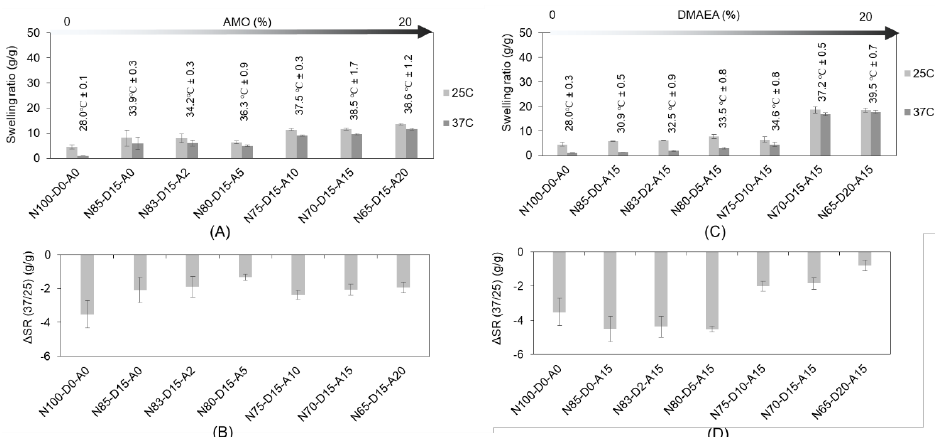
Figure 4. Swelling behavior of three-dimensional scaffold printed from GF-based resins (3% w / w TMPTA, 4% w / w PI, printing time 10 s/layer) at different temperatures (25 °C and 37 °C) with the transition temperature with different ratios of ( A ) AMO and ( B ) DMAEA. The corresponding ΔSR (37/25) is shown in charts ( C ) and ( D ).